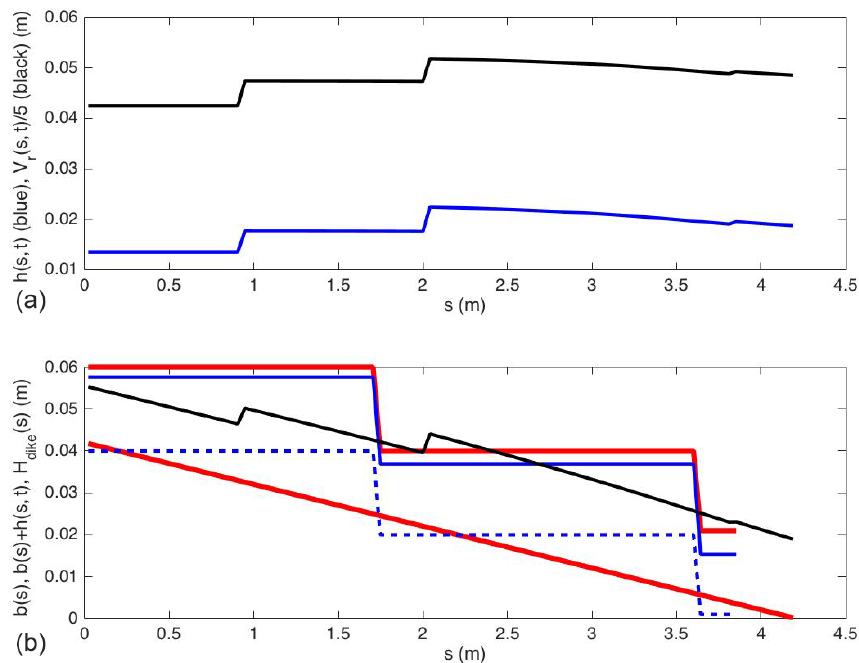
Figure 4. (a) The river level h(s , t) of the river (blue, bottom) and the river velocity V r (s , t) (black, top) as a function of the along-river coordinate s at t = 5000s; (b) topography b = b(s) (in red and fixed), the top of the berm or dike along river/canals in red (fixed); in dashed blue the bottom of the set of canals; in solid blue the canal levels; in black is the dynamic river level indicated above the bed; all as a function of s at time t = 5000s. When the black line/river level lies above the red lines/berms, there is flooding, here because at t = 5000s the water level is seen to be high; cf. Fig. 5d. The black line is seen to have three jumps at s = s res = 0 . 932m, s = s m = 2 . 038m, and a small one at s = L 1c = 3 . 858m, where water comes in from the reservoir, moor, and canal respectively. At s = 0 there is constant water influx. Flooding is just defined as water-level exceedance above the canal berm: in this simplified design model there is no actual water leaving the